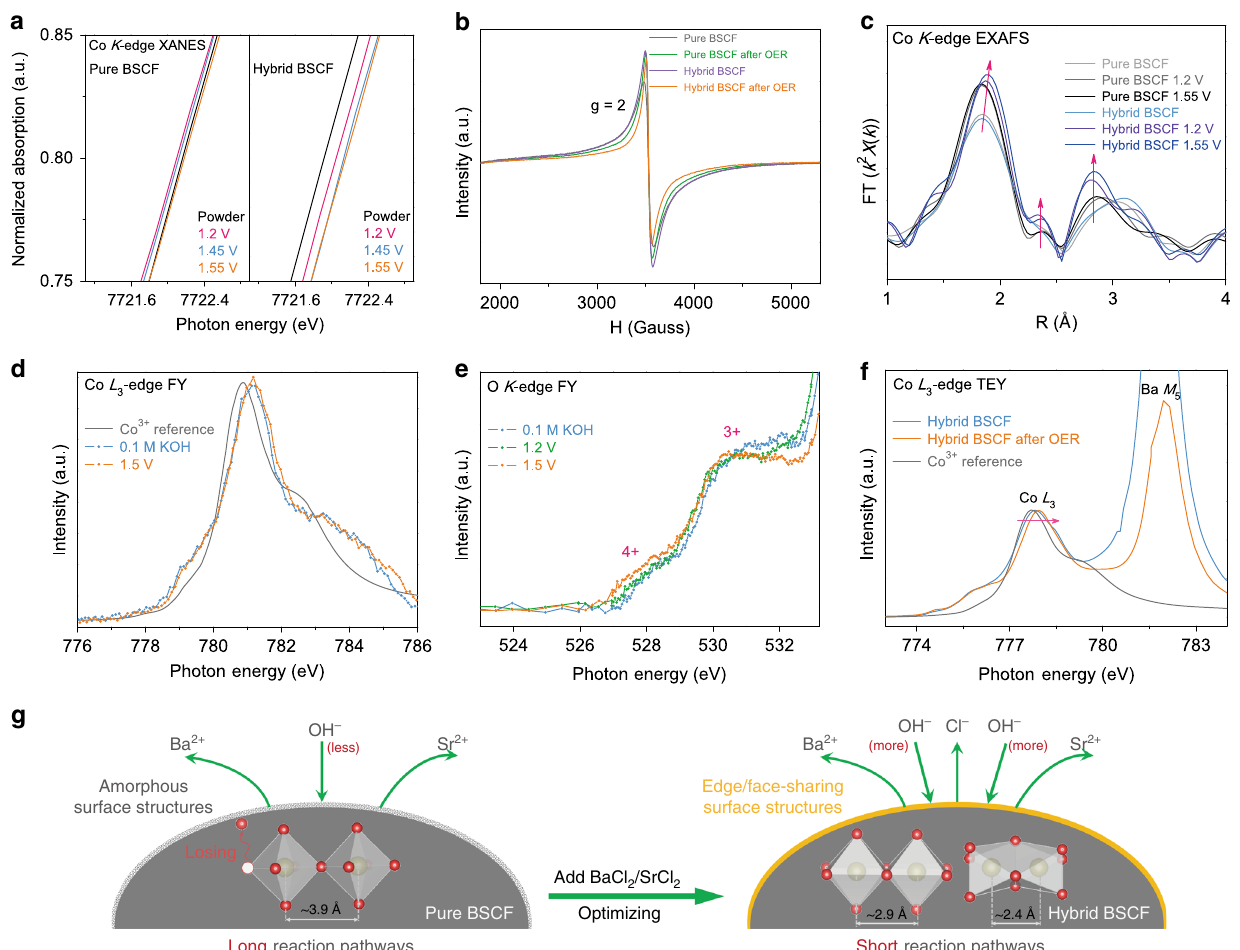
Fig. 4 Operando spectroscopic characterizations and proposed OER catalytic mechanism. a Operando Co K -edge XANES spectra for pure BSCF and hybrid BSCF. b EPR results of samples before OER and after a short-time OER activation. c Operando Co K -edge EXAFS spectra for pure and hybrid BSCF samples (with phase correction). Operando soft XAS spectra at d Co- L 3 and e O- K edges in FY mode. f Ex situ soft XAS spectra at Co- L 3 and Ba- M 5 edges in TEY mode. g Schematic presentations of proposed self-optimizing OER mechanism, where corner-sharing, edge-sharing, and face-sharing Co – Co/Fe metal sites show interatomic distances of 3.9, 2.9, and 2.4 Å, respectively. Single crystal EuCoO 3 was used as the Co 3 + standard for Co L 3 -edge